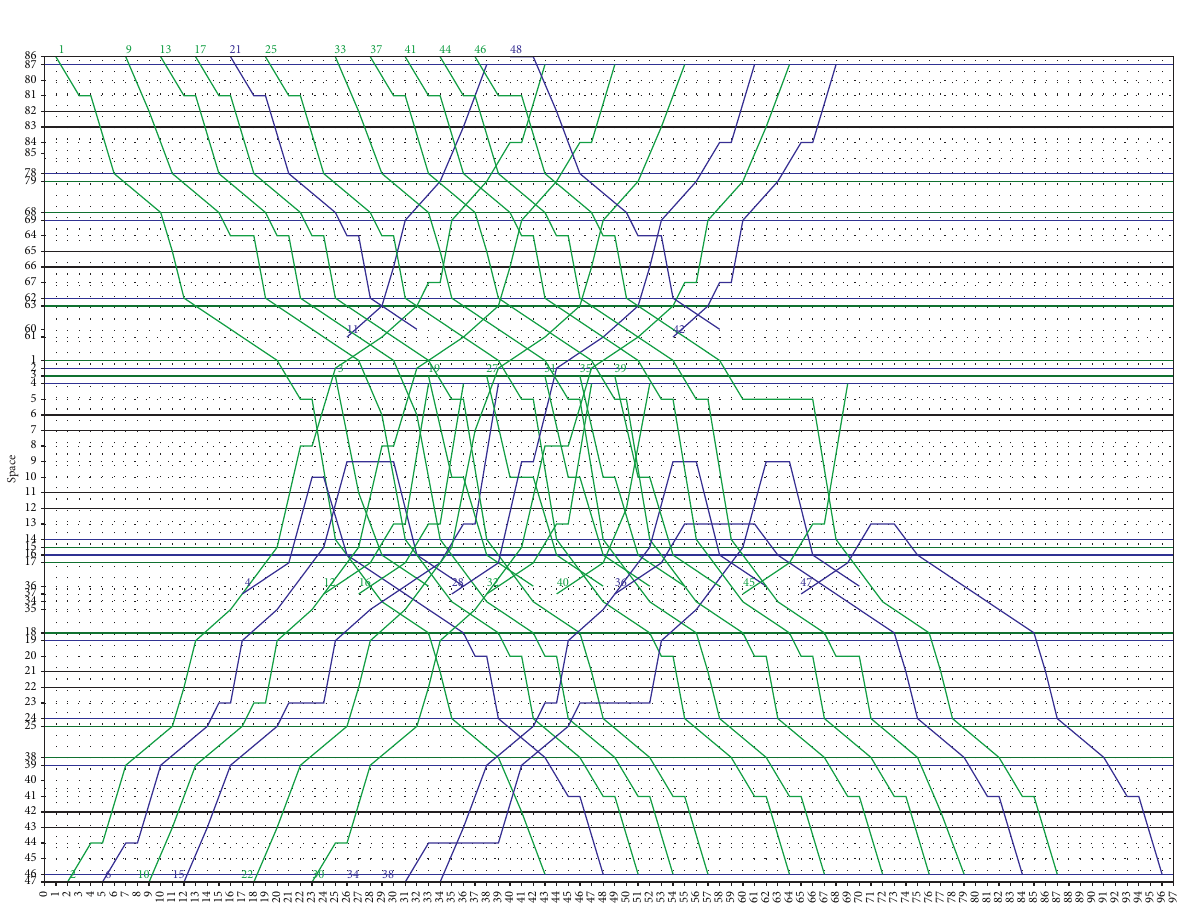
Figure 11: Train timetabling and platforming result for Line 1 for medium-sized rail network.